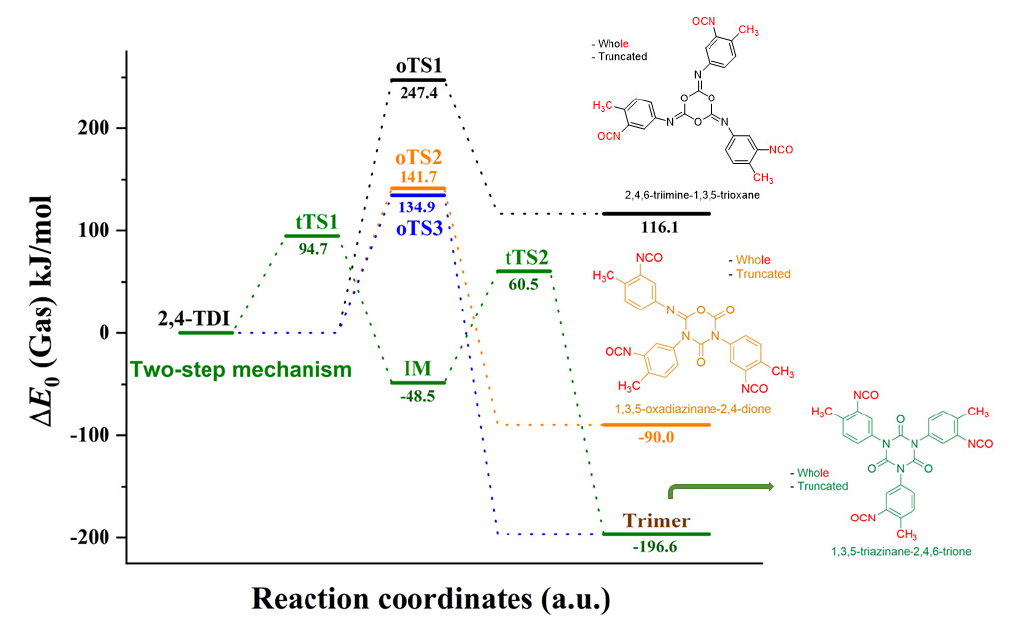
Figure 6. Zero-point energy profile for the trimerization of TDI in the gas phase. The energy values were obtained using the qG3MP2B3 protocol.